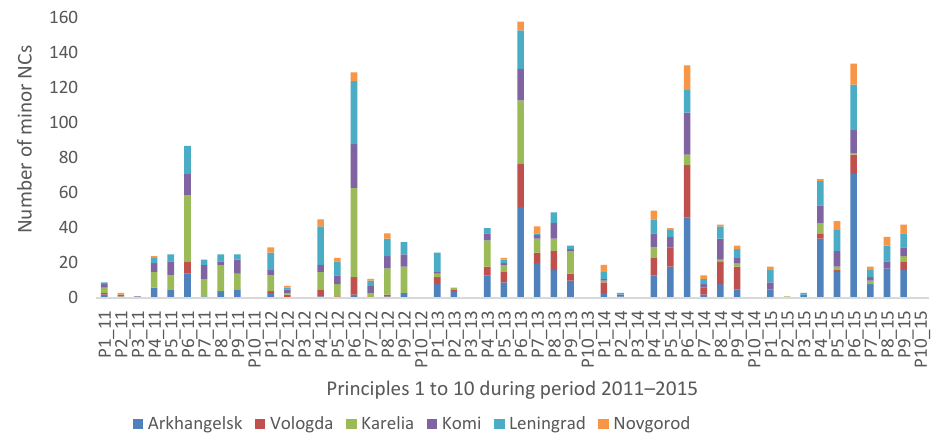
Figure 1. Distribution of minor non-conformities (NCs) among the regions in the period 2011–2015.